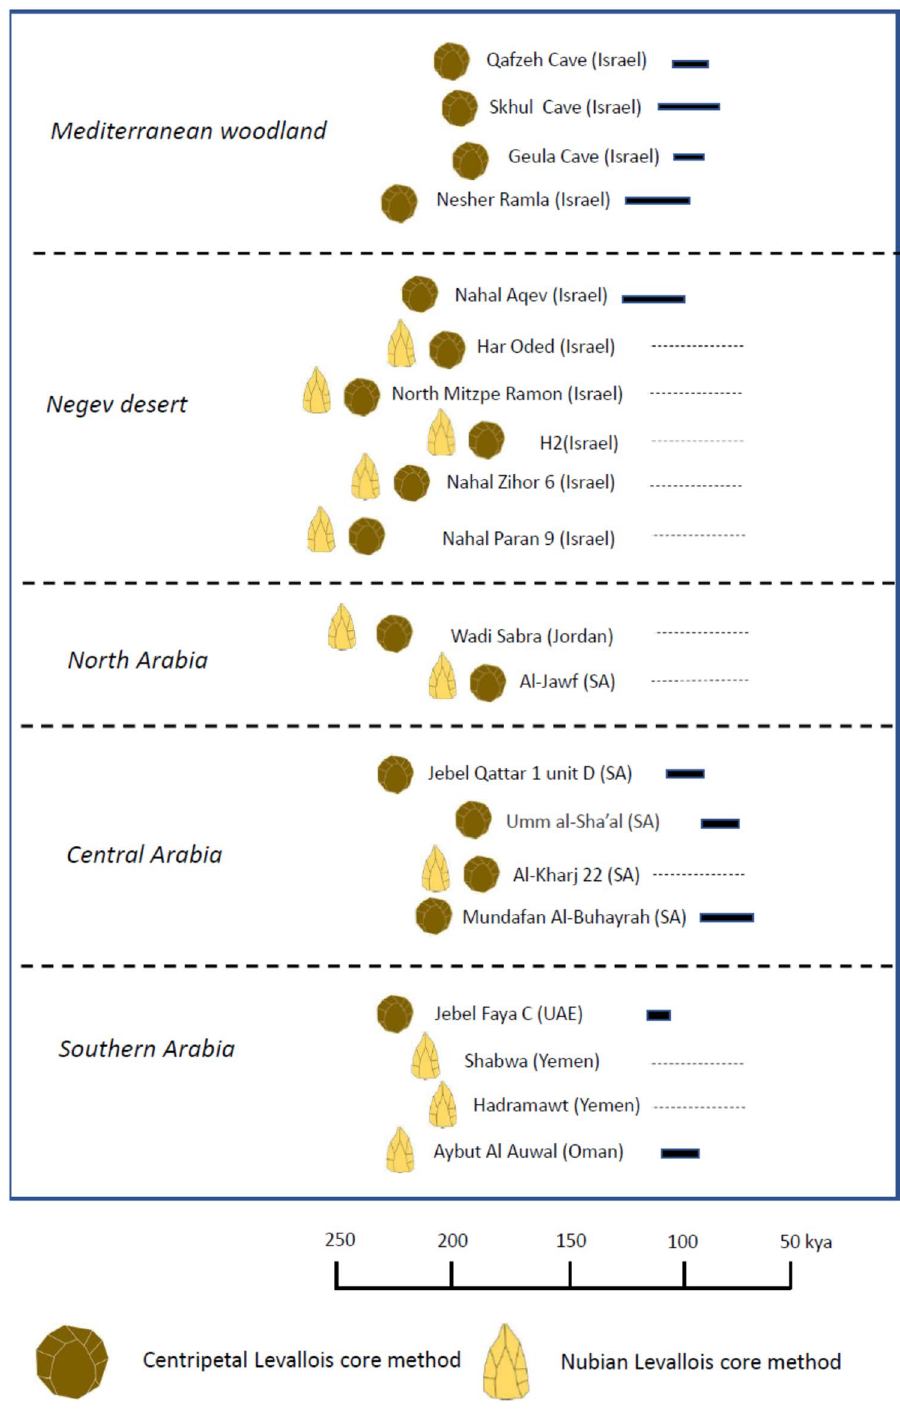
Figure 6. Range of ages (bars on the right) and lithic industry of MIS 5 sites from the Mediterranean woodland, Negev desert and the Arabian desert 9,15–17,24,27,28,66,68–72 . Note that Centripetal Levallois and Nubian Levallois dominate the Mediterranean woodland and southern Arabia, respectively. Solid bars stand for numerical ages and dashed line for age estimates. The only dated site in the Negev desert (this study), Nahal Aqev, is dominated by Centripetal Levallois. Figure 6 was prepared by O.